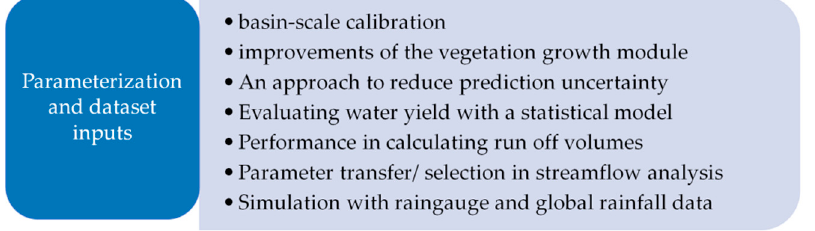
Figure 7. Applications considering model parameterization and dataset